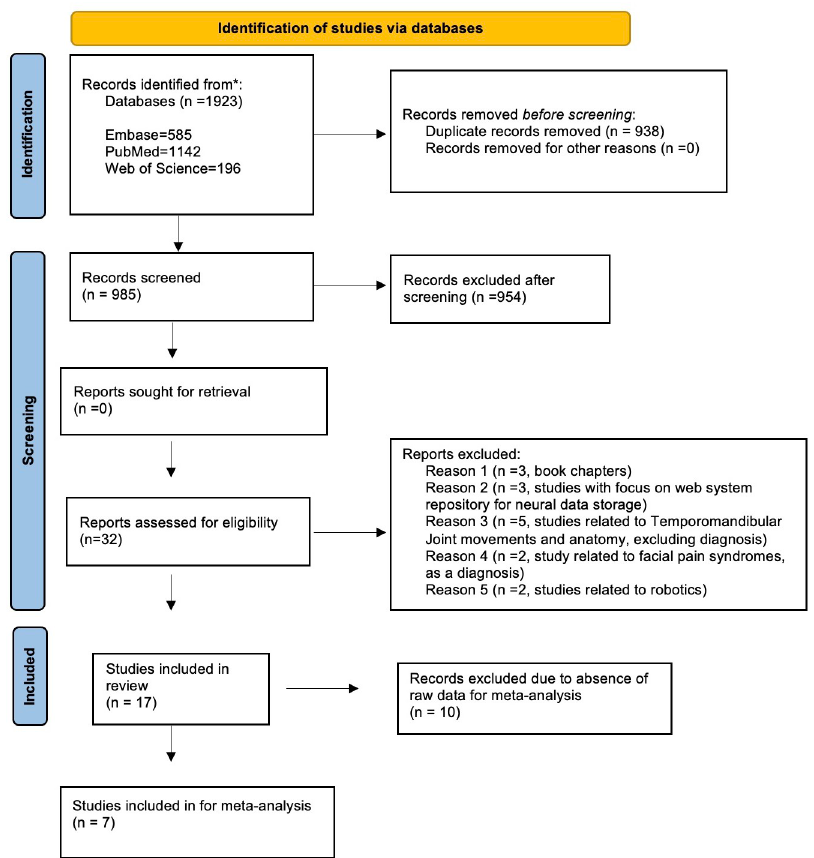
Fig 1. PRISMA flowchart for screening and identifying the included studies.